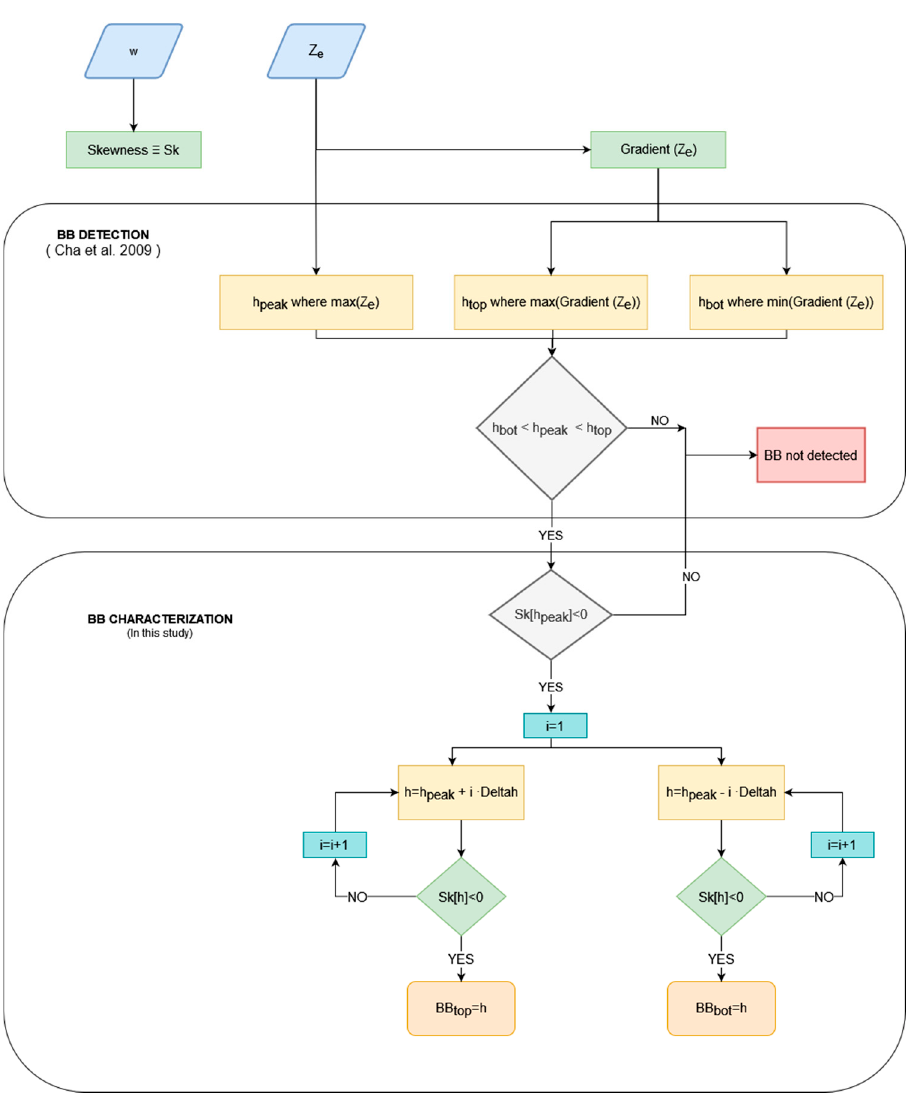
Figure 9. Bright Band (BB) detection and calculation of BB bottom ( BB bot ) and BB top ( BB top ). The Deltah parameter is equal to the vertical resolution of the radar data.